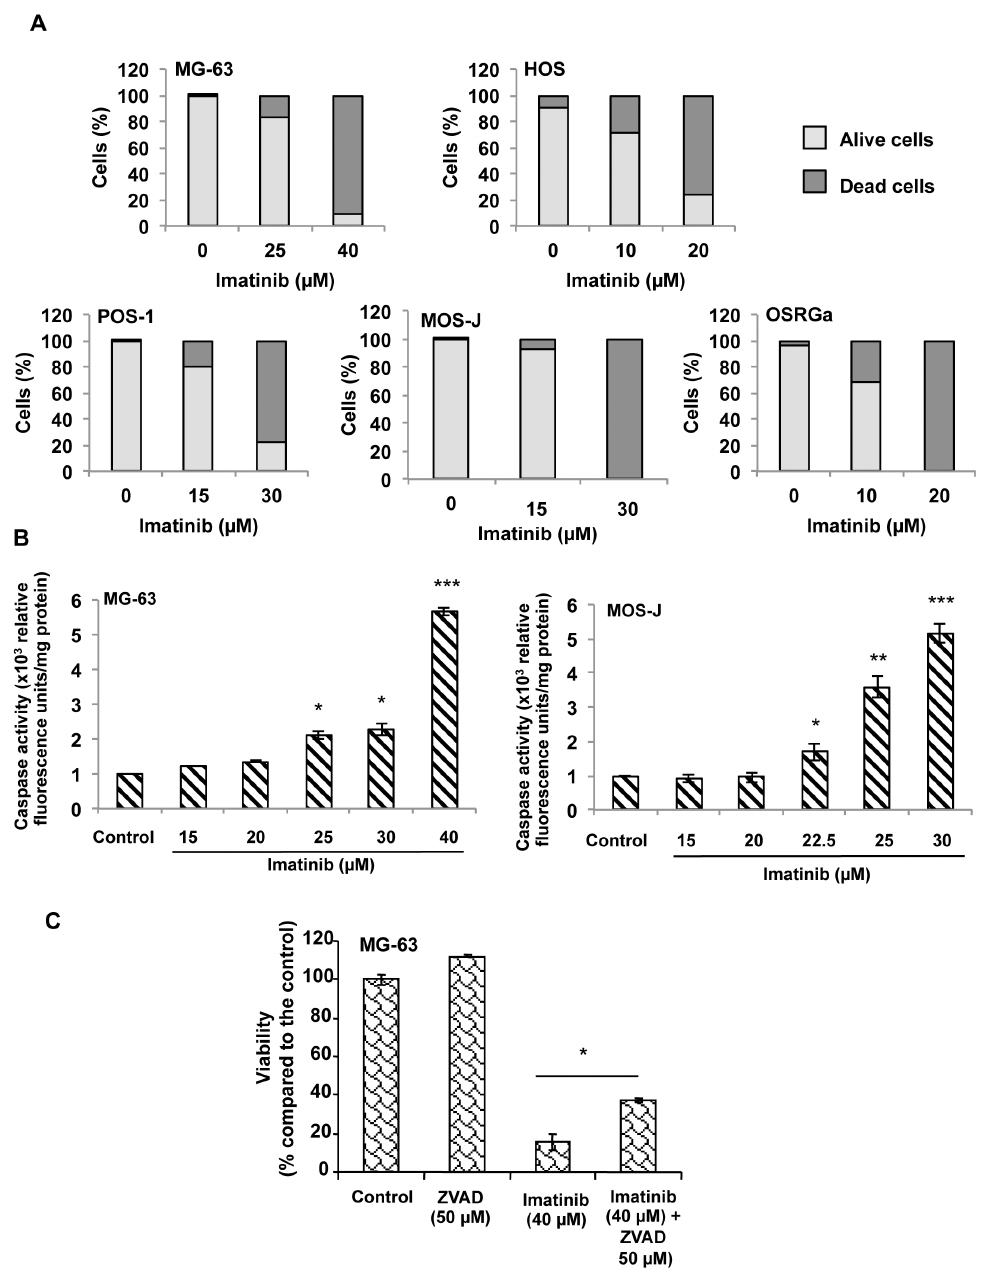
Figure 5. Osteosarcoma cell death induced by imatinib mesylate is partly dependent of caspase activity. ( A ) Human (MG63, HOS), mouse (POS-1, MOS-J) and rat osteosarcoma cells were cultured with or without increasing concentrations of imatinib mesylate. After 48 days of treatment, the alive and dead cells number was manually scored (from trypsinized and floating cells) after trypan blue exclusion. ( B ) Using similar culture conditions, caspase-3 activity was assessed using a kit CaspACE Assay System (Promega, USA). ( C ) On the same way, the involvement of caspase activity in cell death induced by imatinib mesylate was analyzed using the 2,3-bis(2 methoxy-4 nitro-5-sulfophenyl)2H-tetrazolium-5- carboxanilide (XTT) assay in the presence or the absence of 50 m M pan-caspase inhibitor Z-Vad-FMK(ZVAD).*p , 0.05; ** p , 0.01; ***p , 0.001. used to study the efficacy of this therapeutic agent on the primary tumour growth at the bone site. The data revealed the inhibitory activity of imatinib mesylate in undifferentiated- and mixed osteoblastic 2 /osteolytic forms of osteosarcoma, in ‘‘preventive’’ and ‘‘curative’’ approaches. Finally, PDGFR a , Axl, PDGFR b , RYK, EGFR, EphA2, EphA10 and IGF1-R are key targets of imatinib mesylate in osteosarcoma.